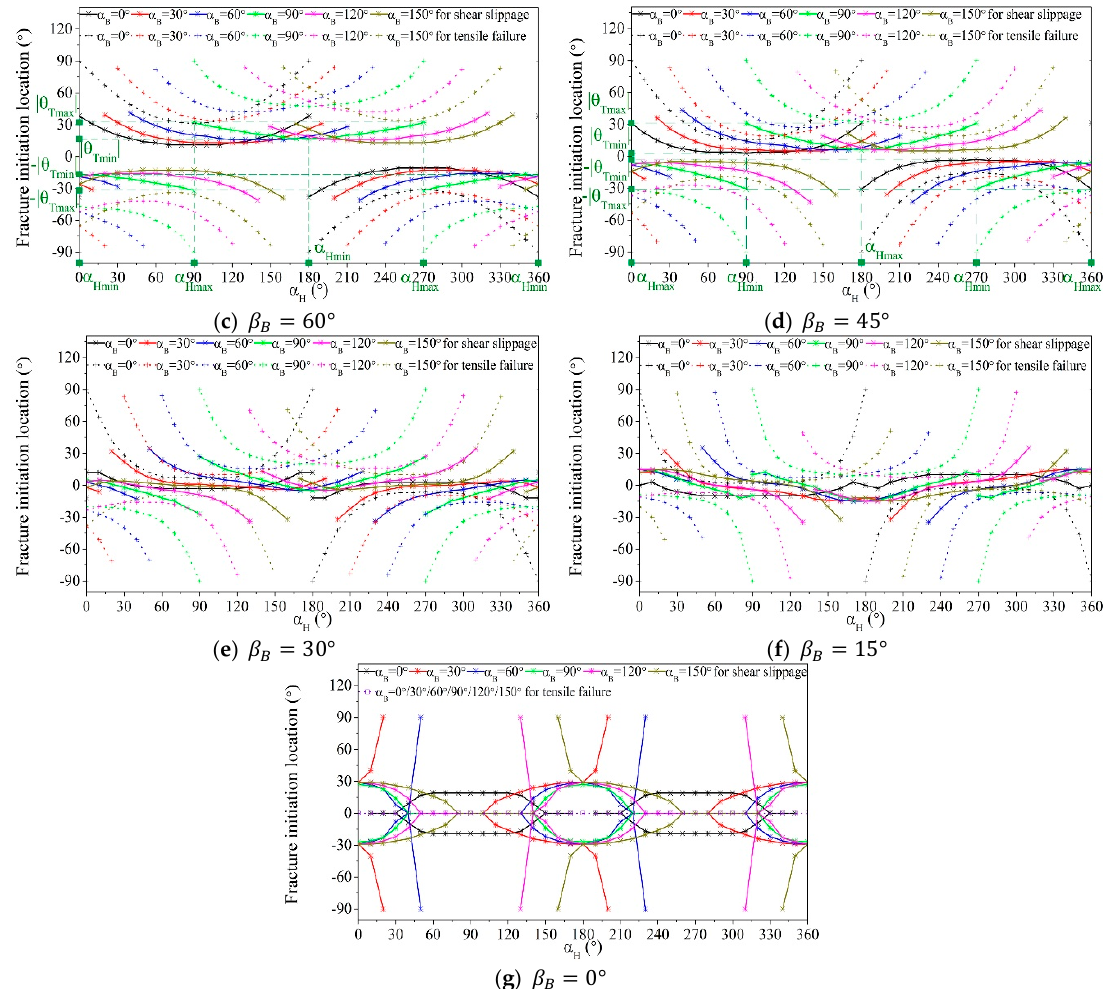
Figure 9. Variation in fracture initiation location ( − 90°–90°) of the bedding planes with drilling direction for different bedding planes for the dip angle of ( a ) 0°, ( b ) 15°, ( c ) 30°, ( d ) 45°, ( e ) 60°, ( f ) 75°, ( g ) 90°. The different colors ( black , red , blue , green , magenta and dark yellow ) represent different conditions corresponding to 𝛼 (cid:3003) = 0°, 𝛼 (cid:3003) = 30°, 𝛼 (cid:3003) = 60°, 𝛼 (cid:3003) = 90°, 𝛼 (cid:3003) = 120° and 𝛼 (cid:3003) = 150°, respectively. The different line styles (solid and dotted lines) represent different fracture initiation modes (shear slippage along the bedding planes and tensile failure across the bedding planes, respectively). Besides, the colors (cyan and violet) represent shear slippage along the bedding planes and tensile failure across the bedding planes when the change of 𝛼 (cid:3003) makes no difference to the FIL.